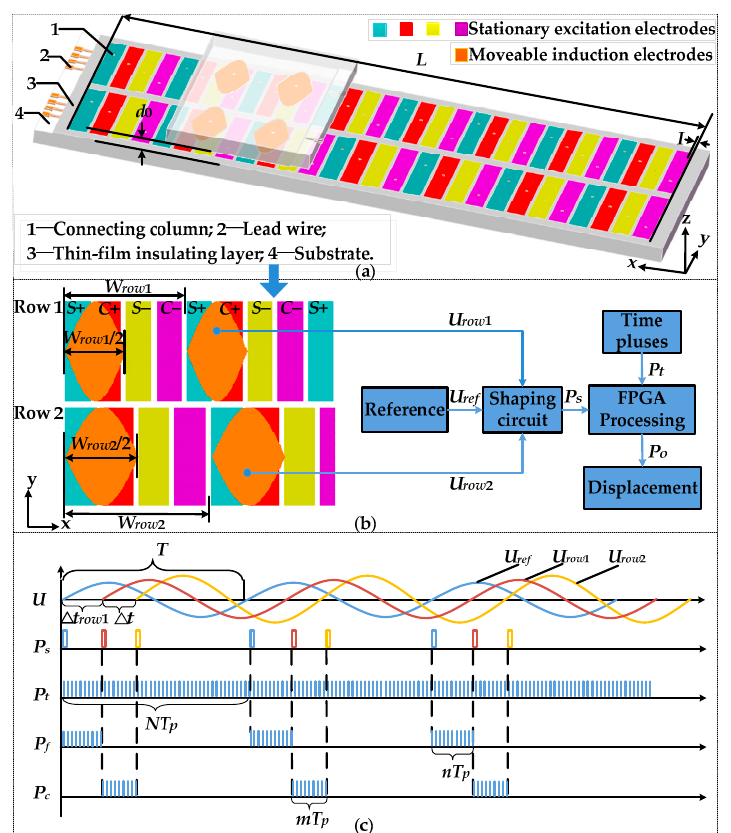
Figure 2. ( a ) Schematic diagram of a double-row Vernier-type capacitive structure for conducting absolute position measurements with time-grating. ( b ) Schematic diagram illustrating the absolute position measurement principle of double-row capacitive structure. ( c ) High-frequency clock pulse interpolation. As shown in Figure 2b, the VATG sensor includes two single-row capacitive sensing structures denoted as row 1 and row 2 with different periodicities of W row 1 and W row 2 , respectively. Because the value of I is equivalent for both rows, the widths of the excitation electrodes in row 1 and row 2 are ( W row 1 /4 − I ) and ( W row 2 /4 − I ), respectively. In addition, L/W row 1 and L/W row 2 are both integers, and L/W row 1 − L/W row 2 = 1. According to (5), the corresponding output voltage signals U row 1 and U row 2 of row 1 and row 2 can be given as